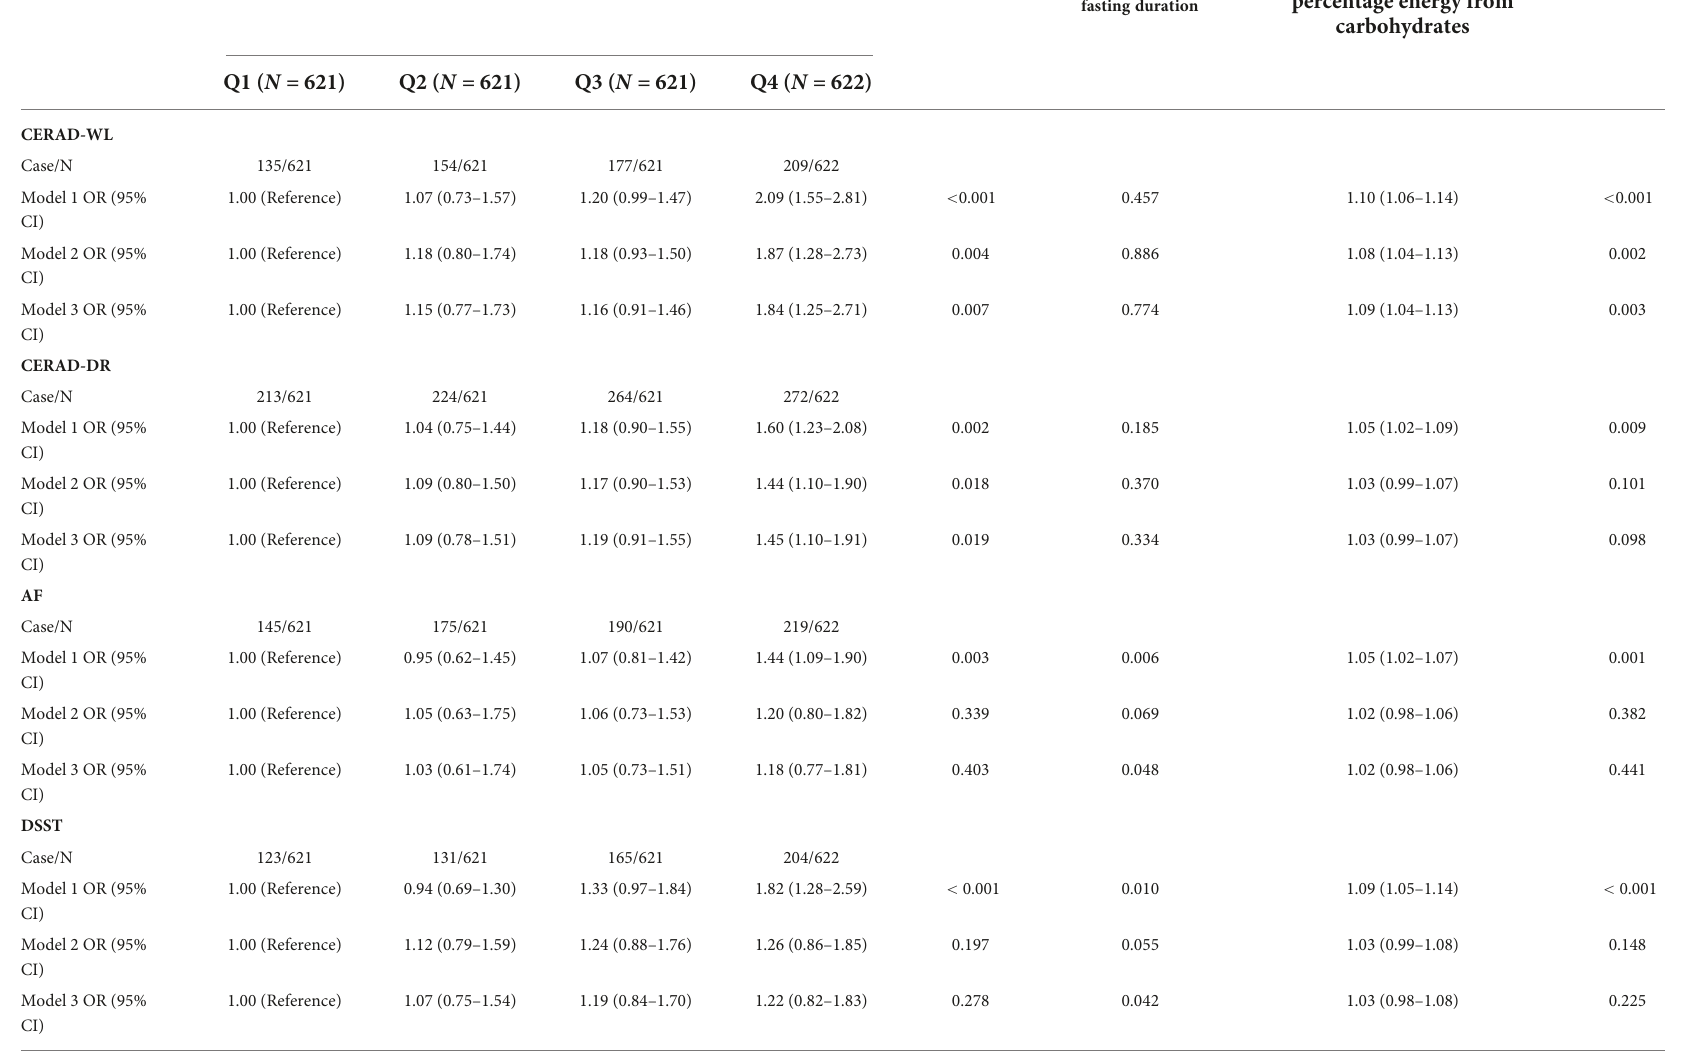
TABLE 1 Association of dietary carbohydrates with poor cognitive performance among total